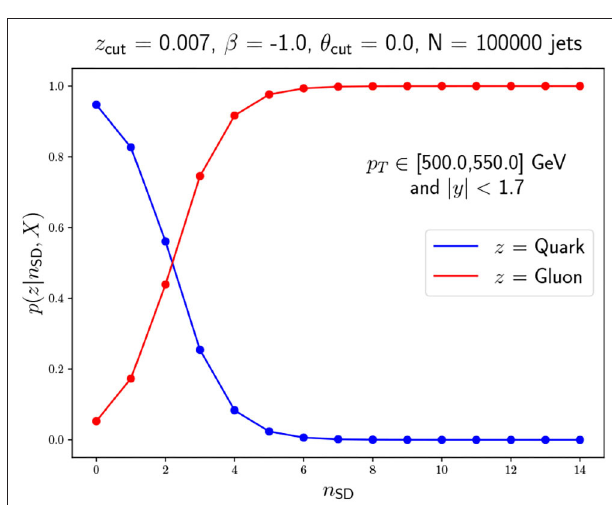
FIGURE 9 | Class assignment probabilities for each n SD possible value obtained after marginalizing over π and λ . Note that each n SD has its own probability mass function with two possible outcomes with no constraint arising from summing over n SD